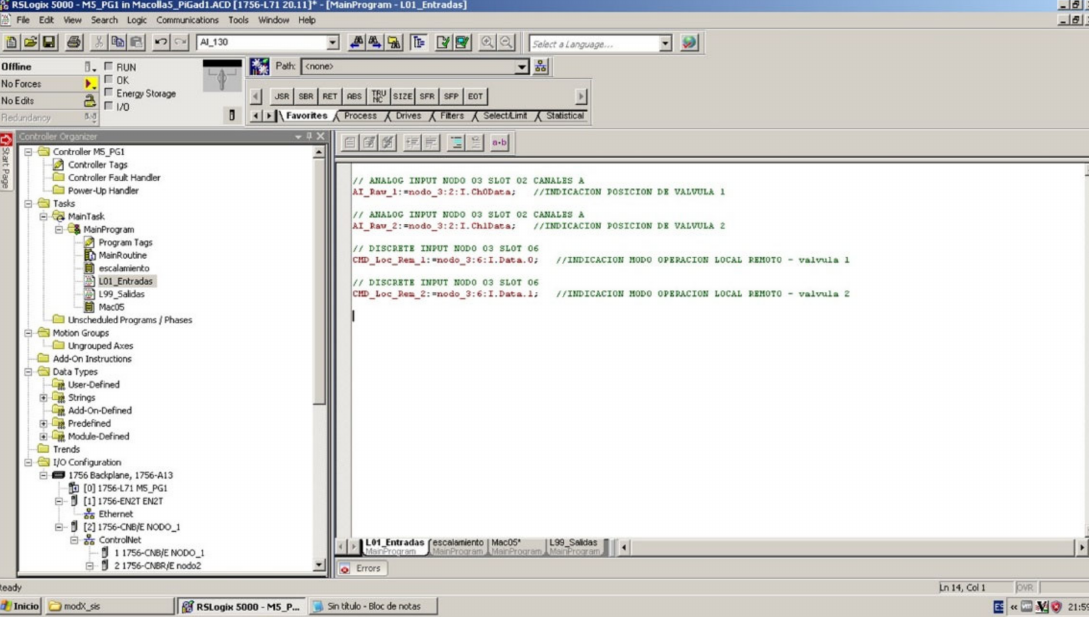
Figure 16. Analog and digital input assignment to